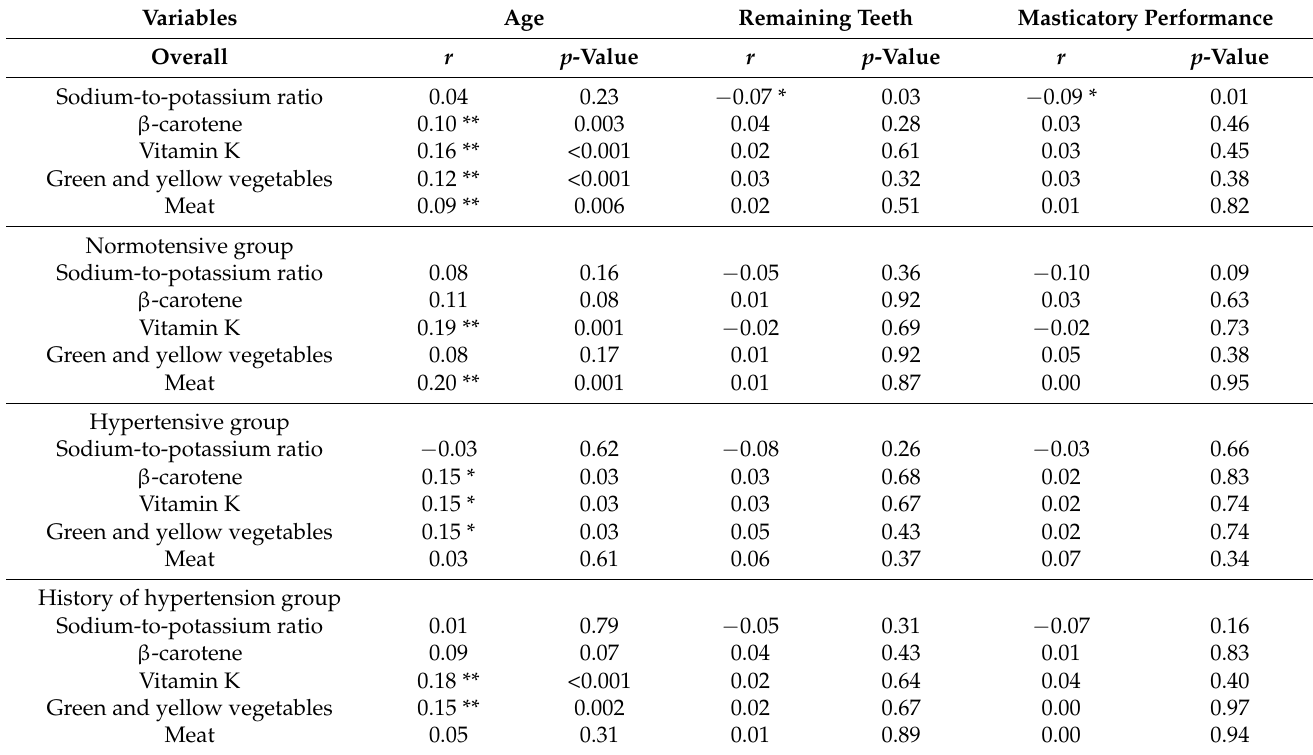
Table 4. Relationship among nutrient, food items, and oral health.